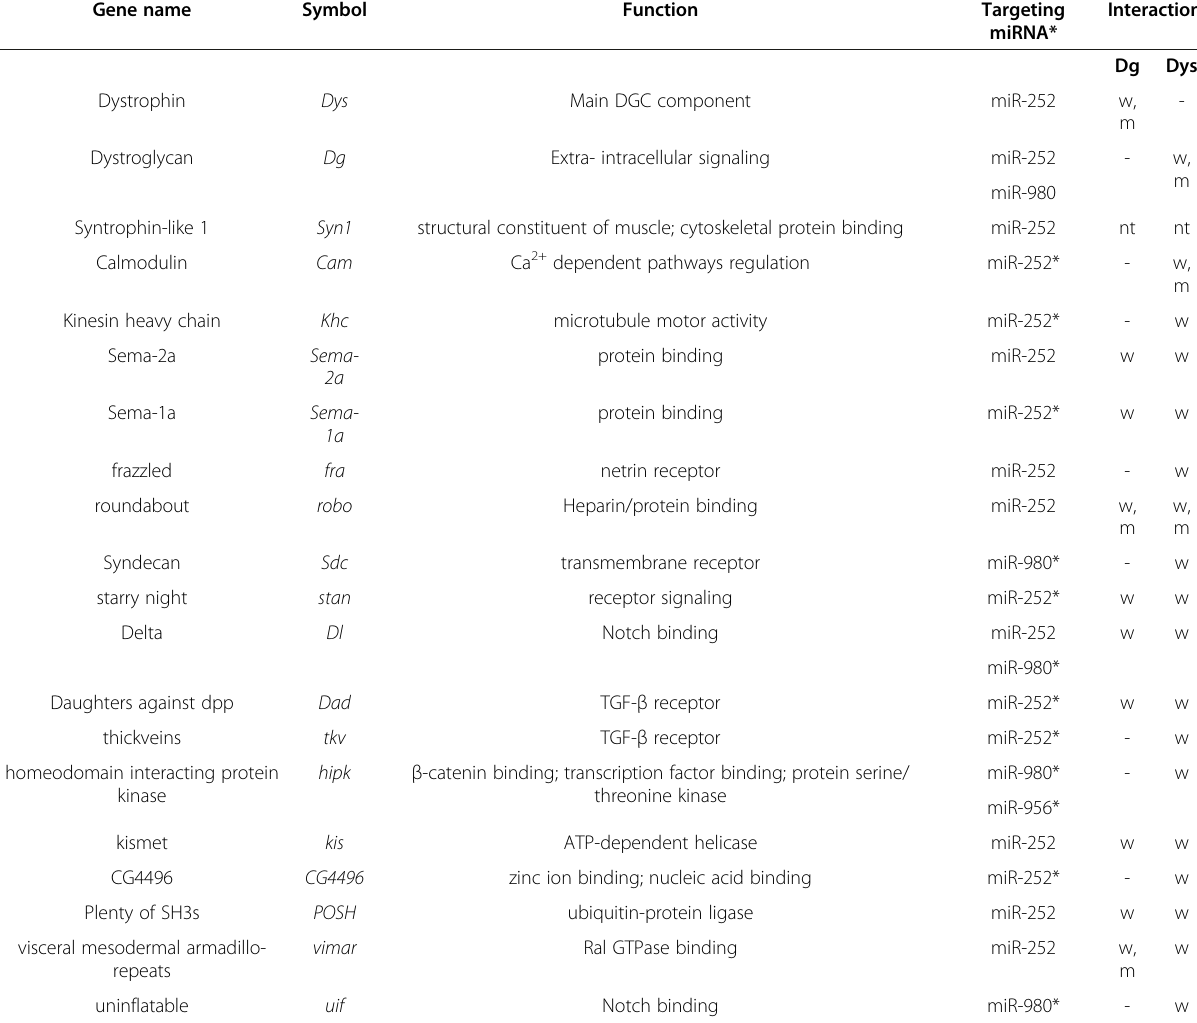
* non-conserved target site among Drosophila species. w - interaction published to occur in wing development [35]. m - interaction published to occur in muscle maintenance [18]. nt = not